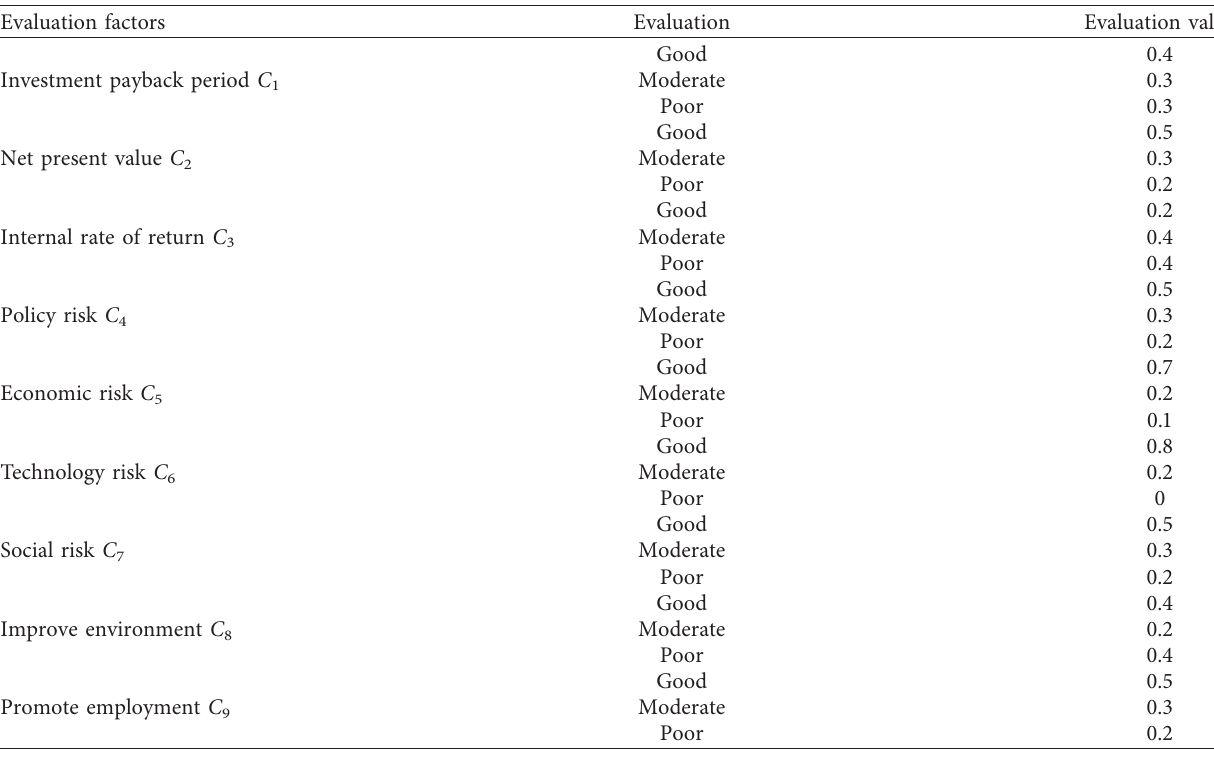
Table 6: Expert’s review